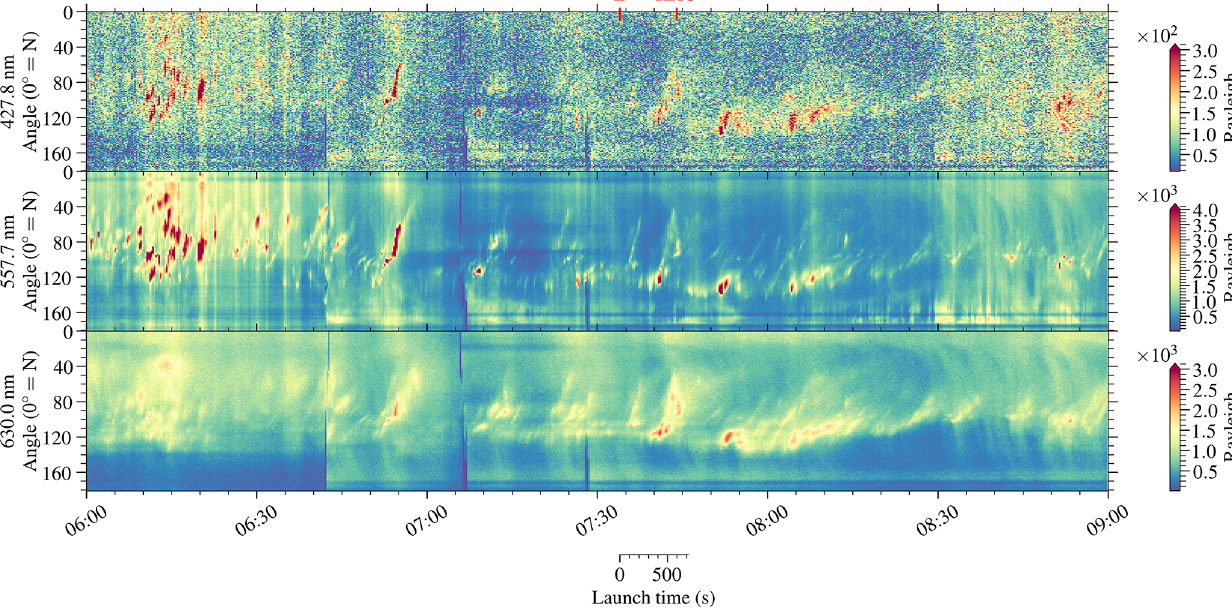
Figure 2. The MSP data from 06:00 to 09:00UTC. This shows the three recorded wavelengths over the north to south scan along the magnetic meridian. The vertical dark blue stripes are from when the slit covering the MSP was cleaned of snow. L and KHO mark the launch and passing east of